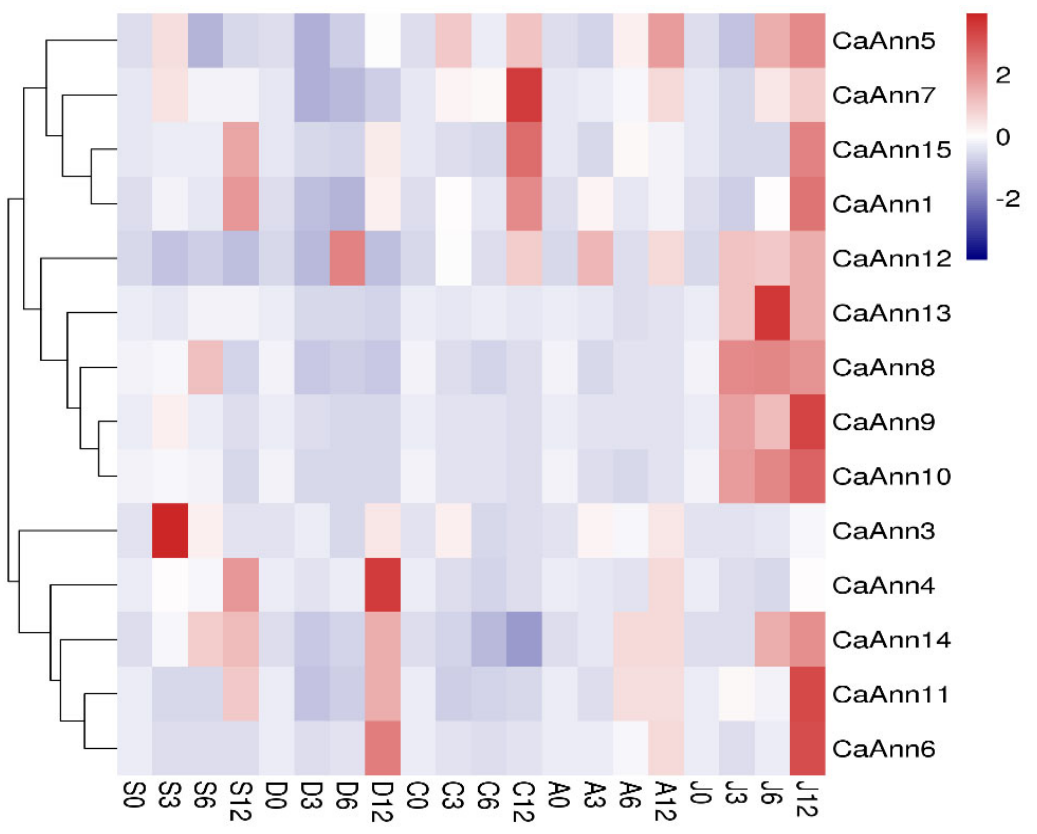
Figure 6. Expression patterns of CaAnn genes under abiotic stresses and plant hormone treatments. One ‐ month ‐ old pepper seedlings were treated with salt (200 mM NaCl), drought (15% w / v PEG6000), cold (4 °C), ABA (100 μ M), and MeJA (100 μ M) for 0, 3, 6, and 12 h. Total RNA was extracted from leaves and used for real ‐ time quantitative PCR. The expression level was normalized against pepper actin 97 and PC2 genes. Each value represents the average relative expression level of the three replicates. The bar in the upper right corner represents the expression value of log2, and different colors represent different expression levels. Red indicates relatively high expression and blue indicates relatively low expression.